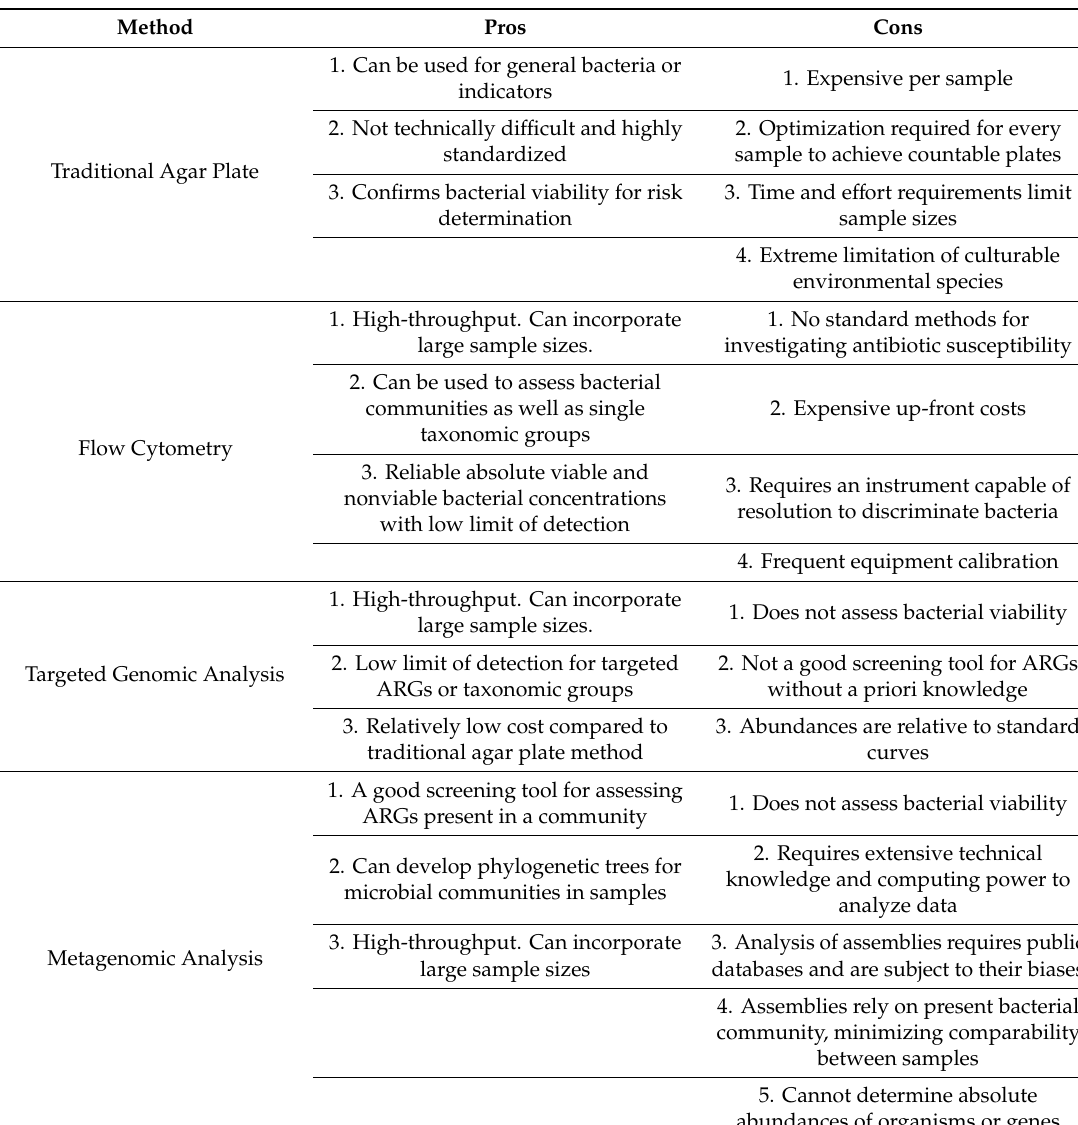
Table 2. Pros and cons of common ARB / ARG analytical